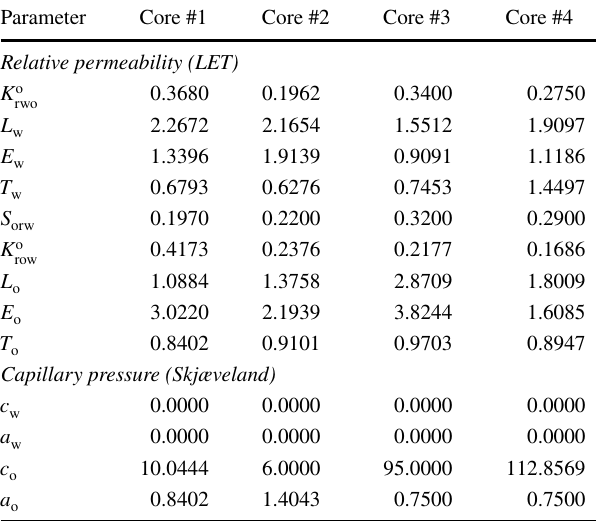
Table 5 Parameters of the relative permeability (LET) and capillary